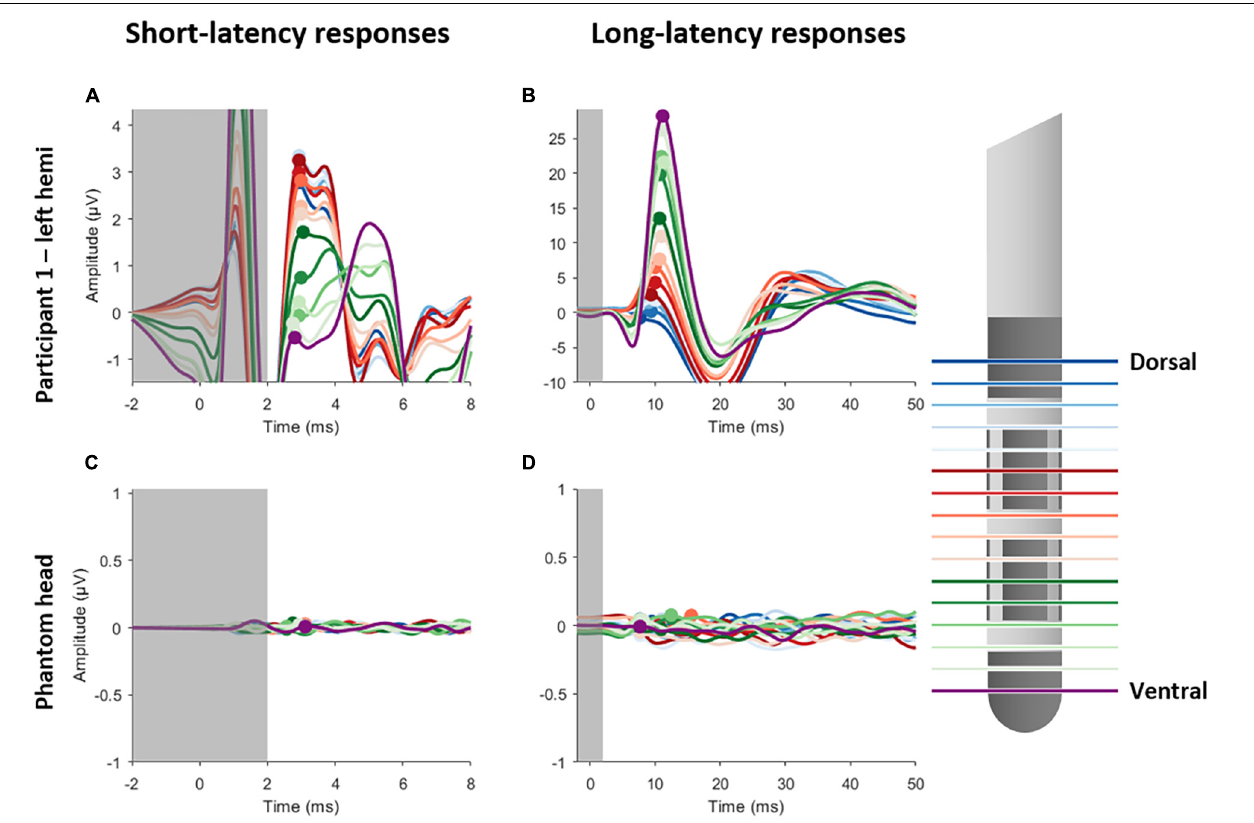
FIGURE 1 | Short- and long-latency EPs recorded whilst employing MICC technology in steps of 20%, yielding a total of 16 EPs. Left panels show the short-latency EPs for participant 1 (A) and the phantom head (C) . Right panels show the long-latency EPs for participant 1 (B) and the phantom head (D) . Each EP is colored differently, as is indicated on the legend on the right side. The gray transparent box indicates the time window (–1 to 2 ms) where residual artifact might still be present. The peak amplitudes are indicated with a circle for P3 (left panels) and P10 (right